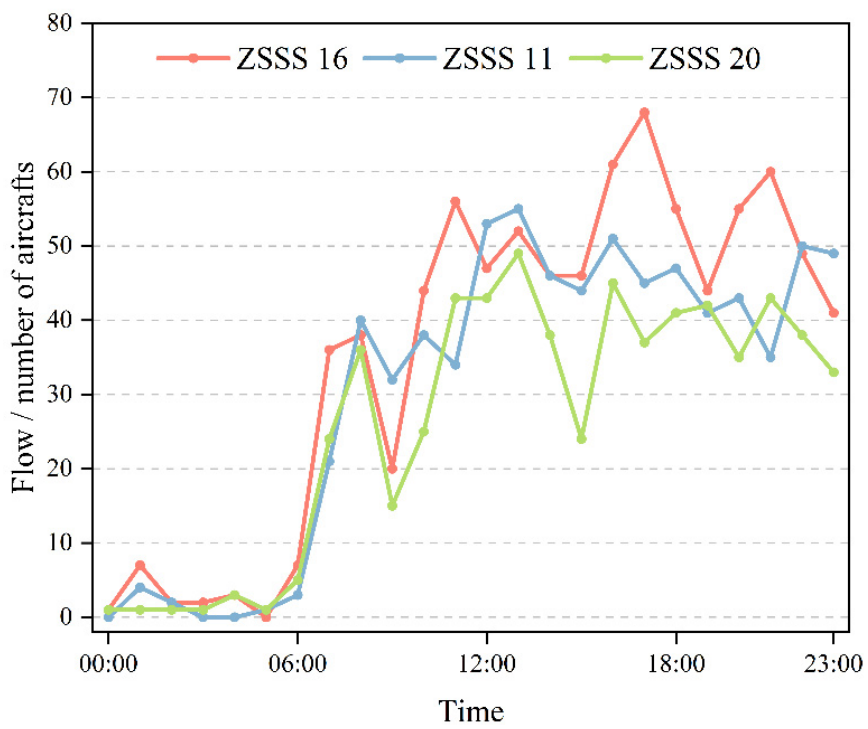
Figure 2. 24-h traffic statistics for control sectors 16, 11, and 20 in the Shanghai control area. Statistics based on flight trajectory data on 6 August 2018.